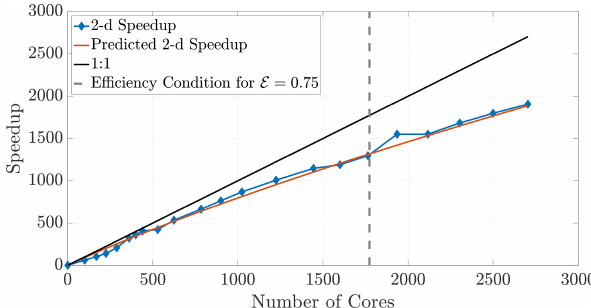
Figure 12. Observed (diamonds) and theoretical speedup for 2-D simulations. Each chosen number of cores is a perfect square so that the checkerboard method gives square subdomains. With the chosen parameters L = 1000, D = 1, and (cid:49)t = 0 . 1 and a desired efficiency of 0.75, the upper bound given by the inequality (29) is not violated for the checkerboard method until around 1700